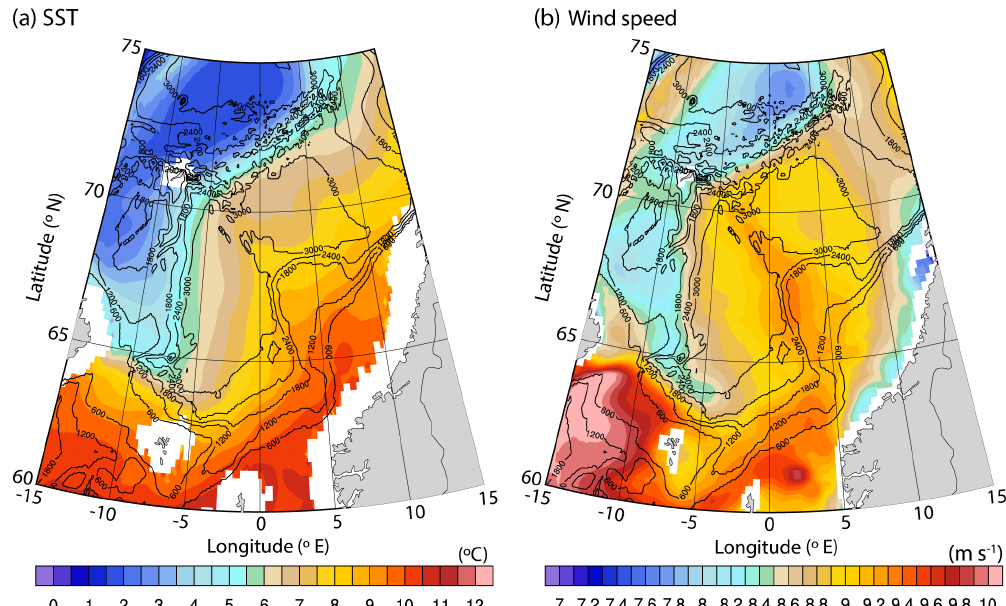
Figure 3. Climatological mean (2002–2009) (a) AMSRE SST ( ◦ C) and (b) QuikSCat wind speed (ms − 1 ). Black isobaths are drawn for every